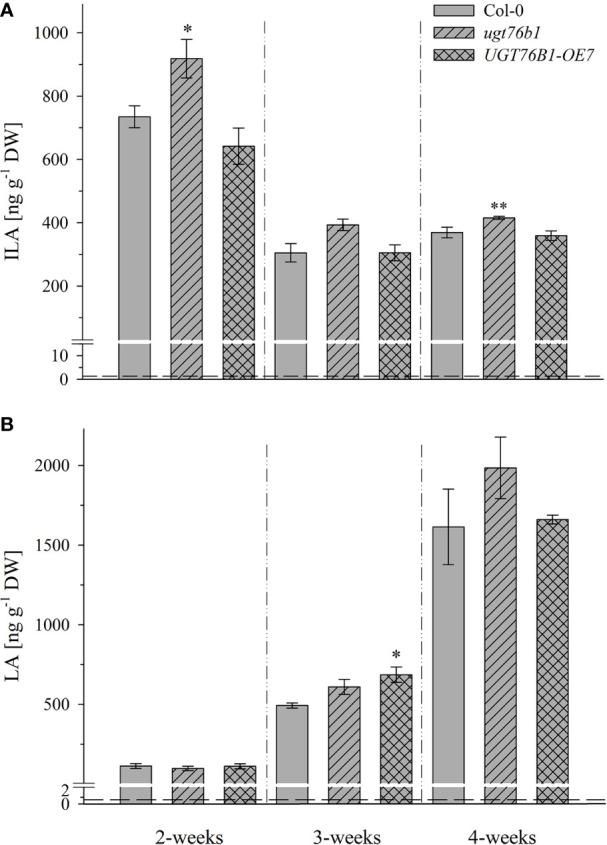
Isoleucic acid and LA abundance in different developmental stages. Levels of (A) ILA and (B) LA in leaves of 2-, 3-, and 4-week-old plants (Arabidopsis thaliana wild-type [Col-0], ugt76b1-1 and UGT76B1-OE7). Plants were grown on soil under short-day conditions (10 h photoperiod). Means ± SE (n = 4) are plotted. Asterisks indicate statistically signiﬁcant differences in comparison to wild type (Col-0) (ANOVA), *p-value < 0.05, **p-value < 0.01. Dashed lines indicate the limit of detection (see section “Materials and Methods”).